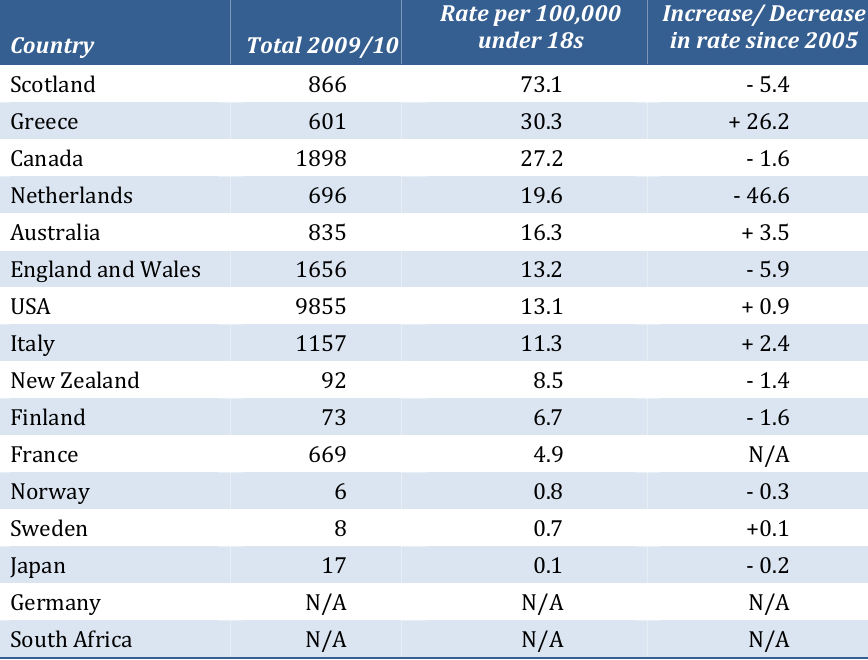
Table 2: Comparing juvenile prison populations (selected countries)